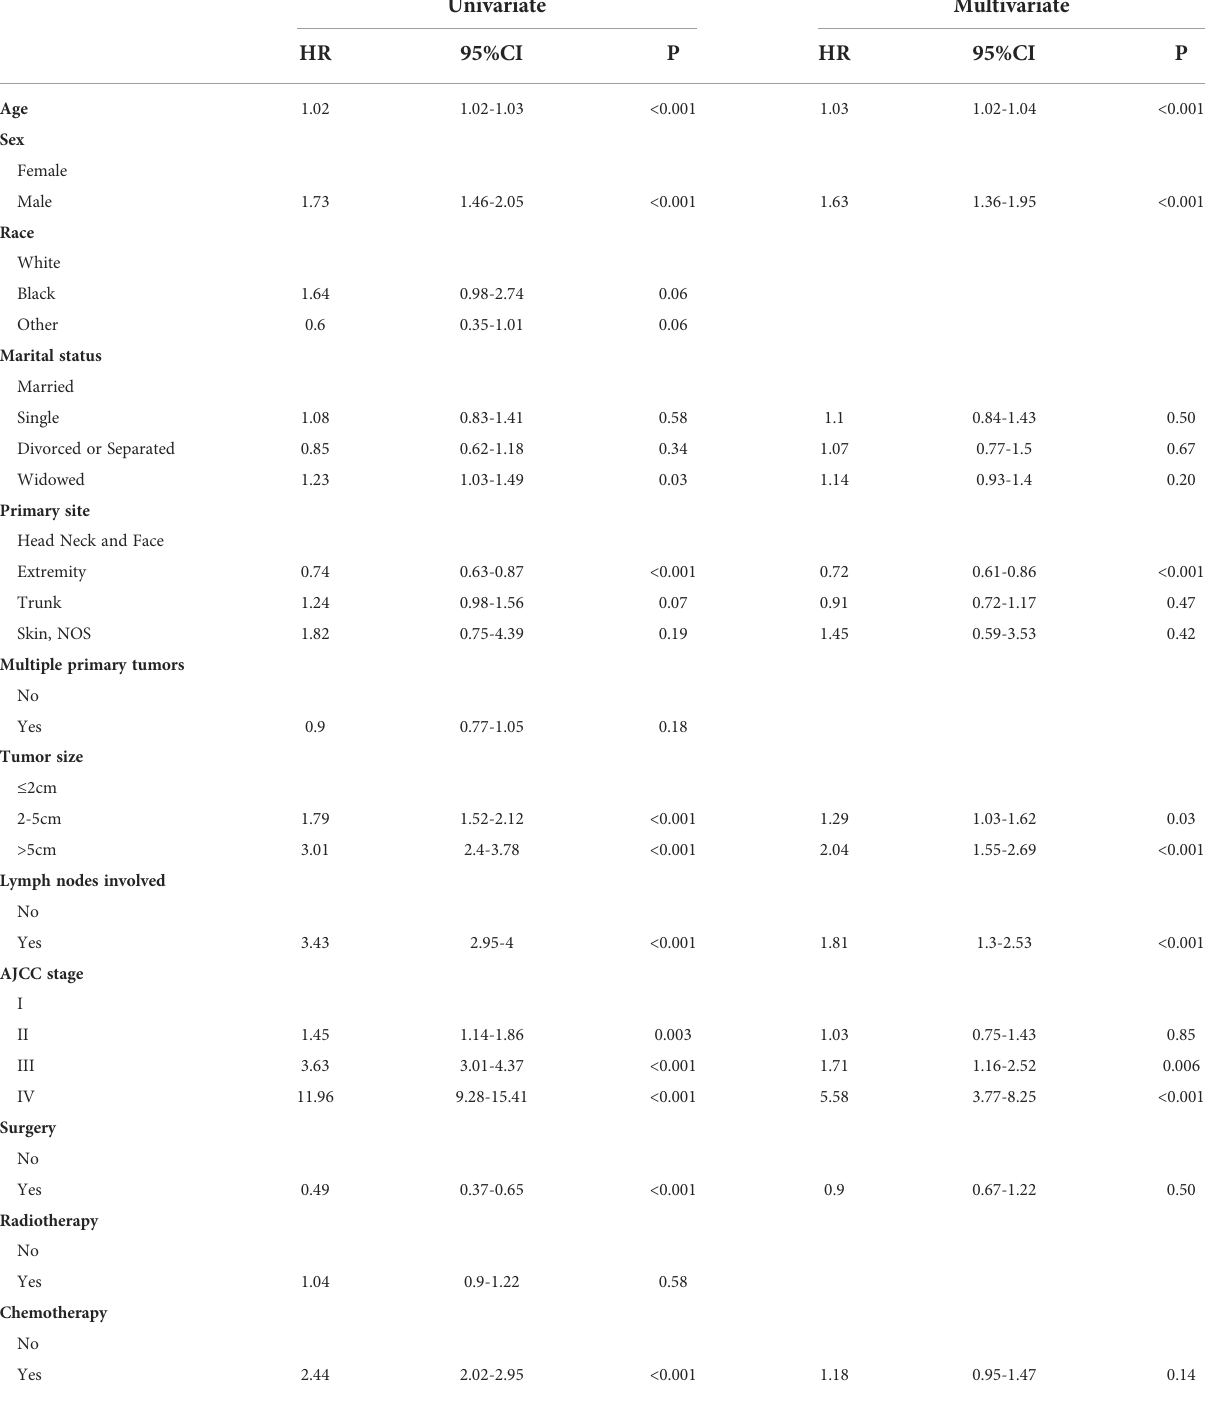
TABLE 3 Univariate and multivariate Cox regression analysis of